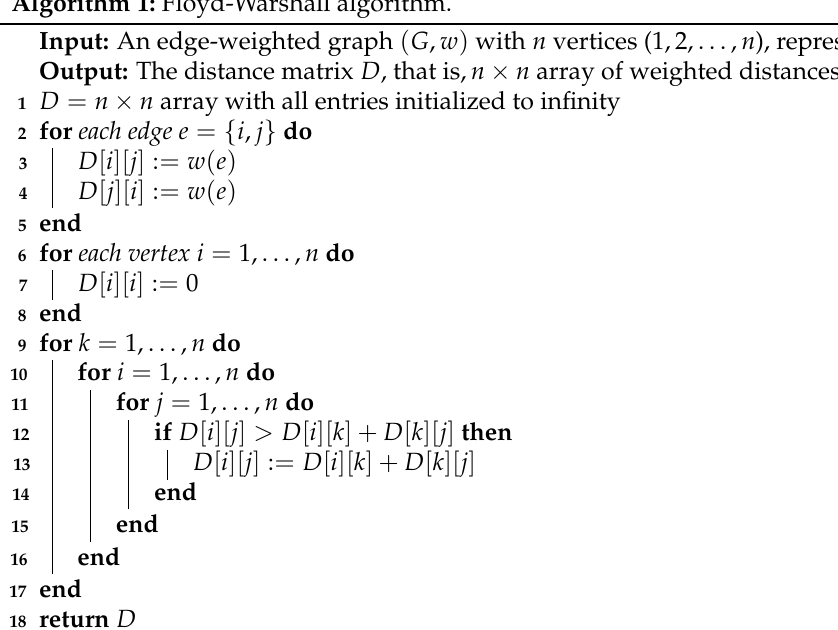
Algorithm 1: Floyd-Warshall algorithm.